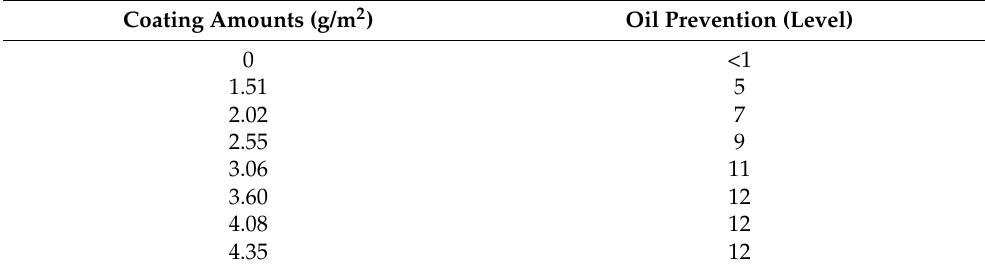
Table 8. Oil resistance of packaging paper with different coating amounts.